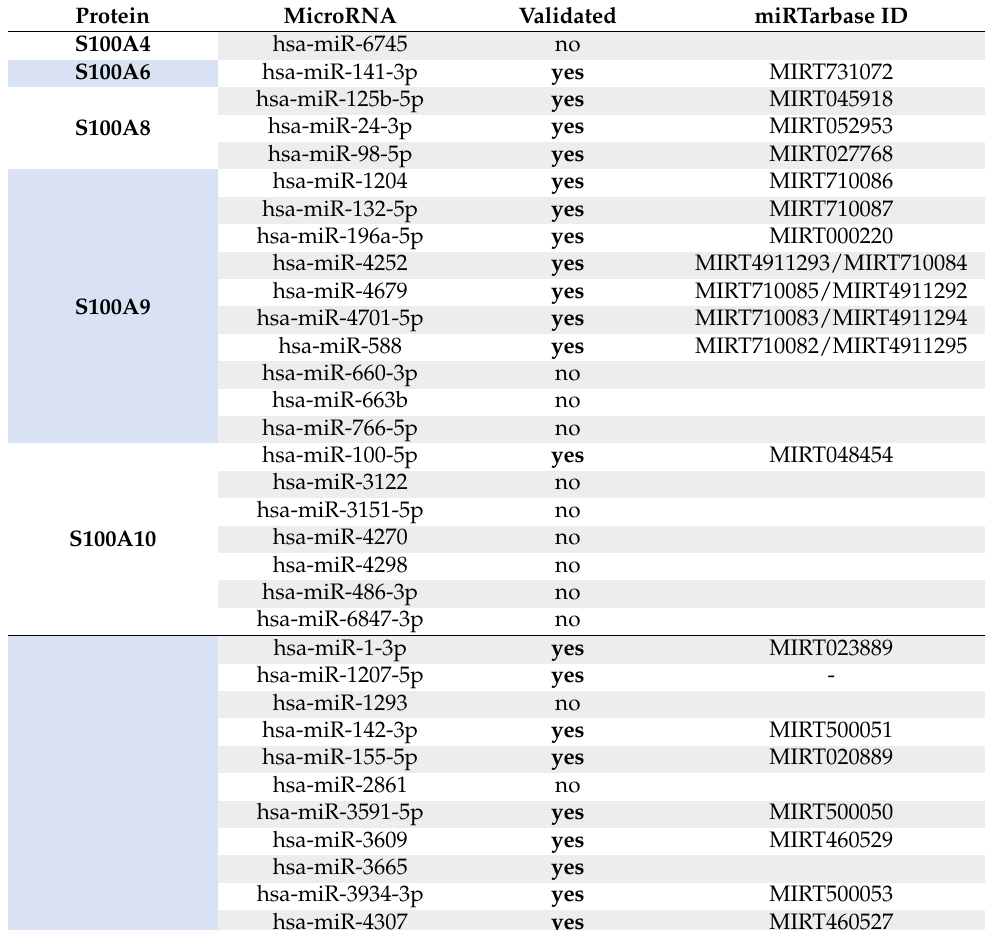
Table 2. Predicted and validated microRNAs potentially regulating S100 protein expression in humans. Protein